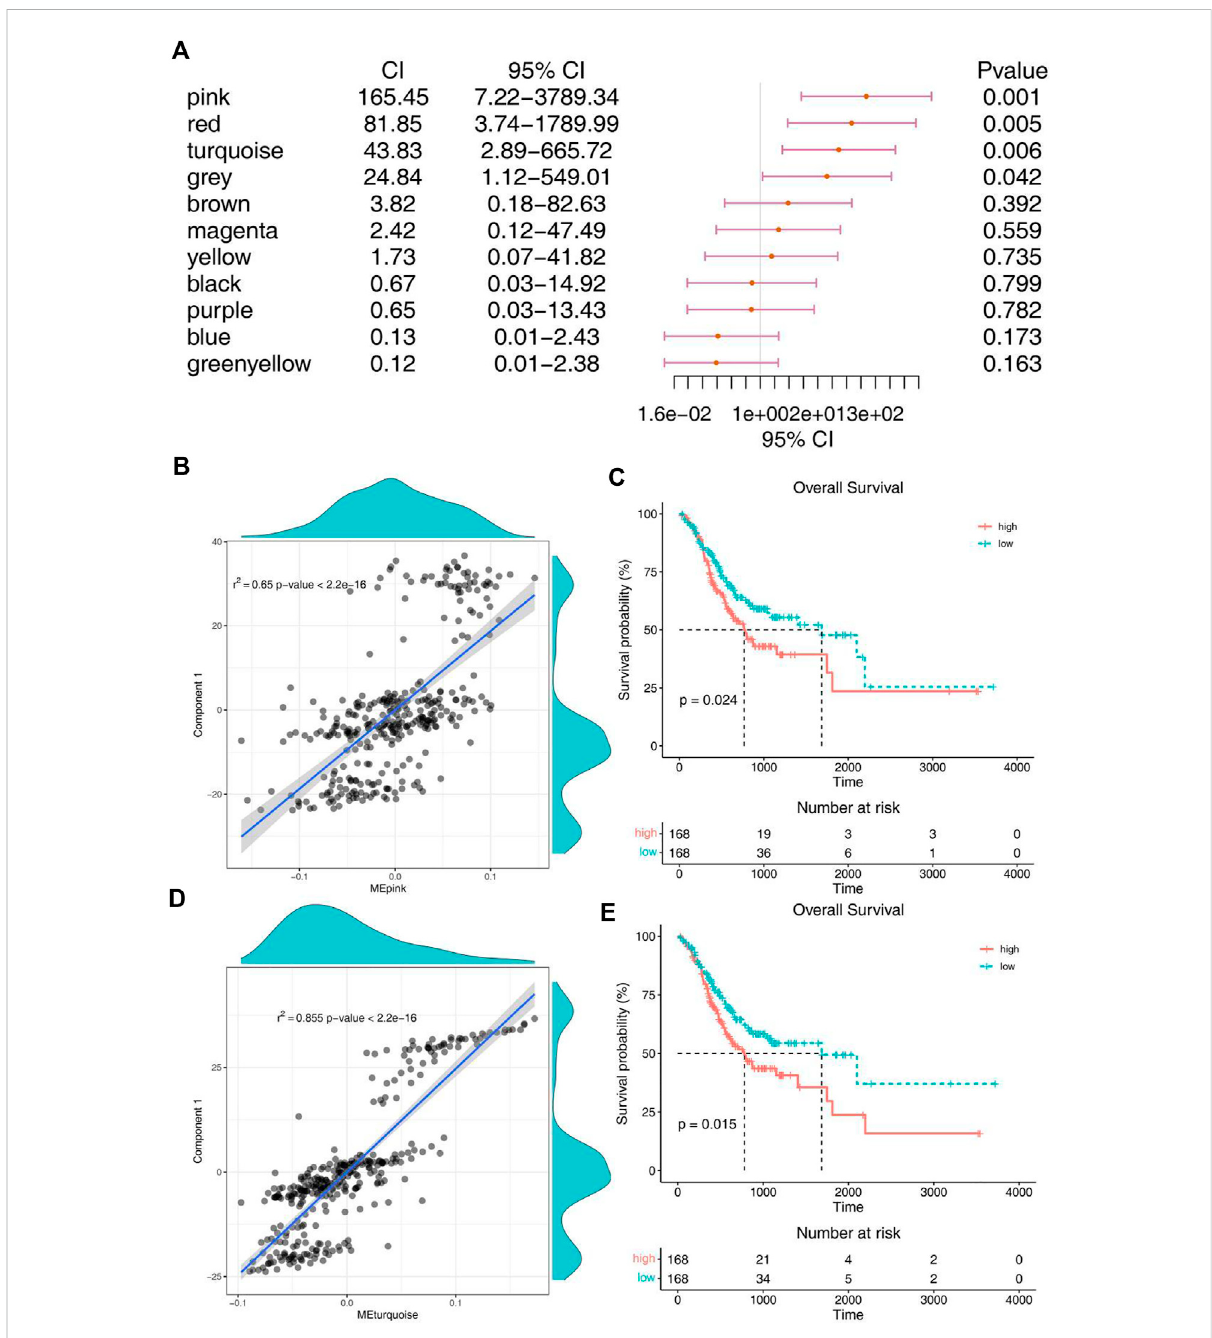
FIGURE 7 Identi fi cation of immune hub genes of STAD. (A) Forest maps of single factor survival analysis of 11 modules of STAD. (B) Correlation between pink module feature vector and principal component 1 in immune landscape. (C) Differential prognosis in pink module with high and low mean. (D) Correlation between turquoise module feature vector and principal component 1 in immune landscape. (E) Differential prognosis in turquoise module with high and low